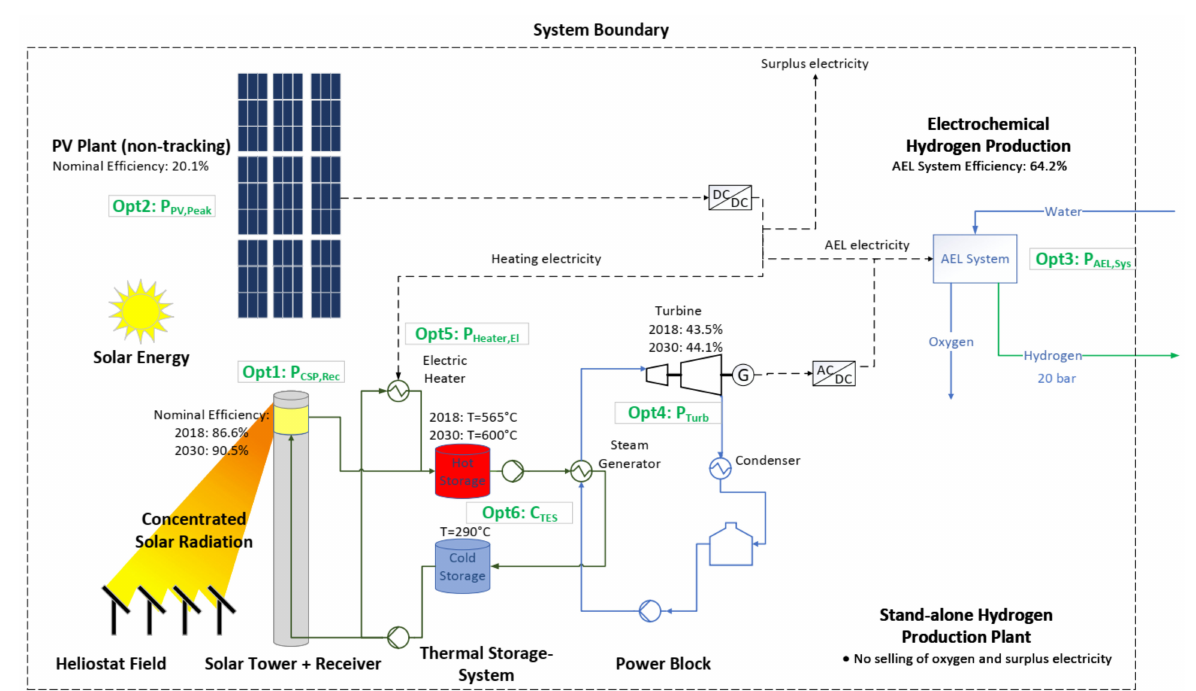
Figure 2. Scheme of the PV/CSP hybrid power plant powering an alkaline electrolyser (AEL) system for stand-alone solar hydrogen production. The six plant design optimization variables are highlighted in green.